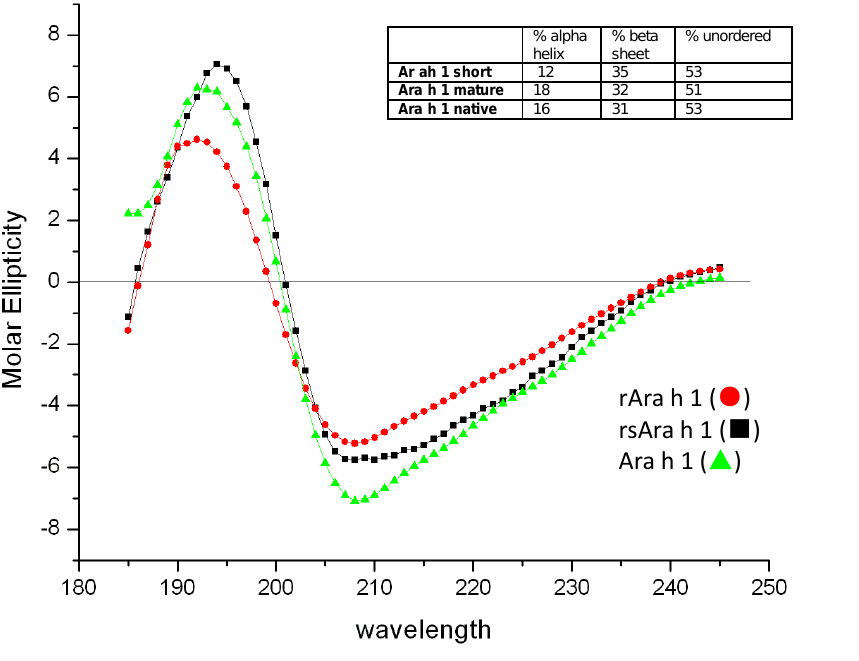
Figure 7. Circular dichroism analysis of rAra h 1 (●), rsAra h 1 (■) and natural of Ara h 1 (▲). The percentage of ordered and disordered secondary structure and shown in the